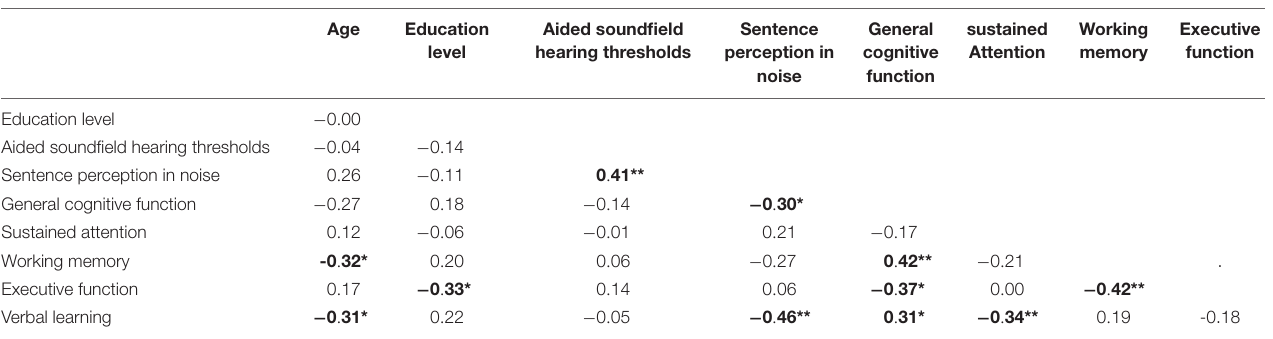
TABLE 3 | Correlations among variables in the HA